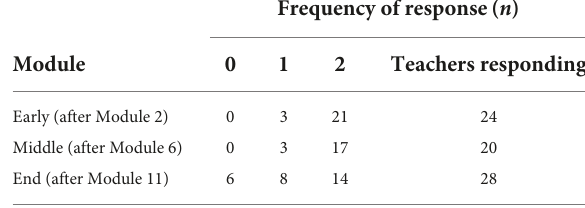
TABLE 7 Teacher responses for “was the time spent on the modules reasonable?”